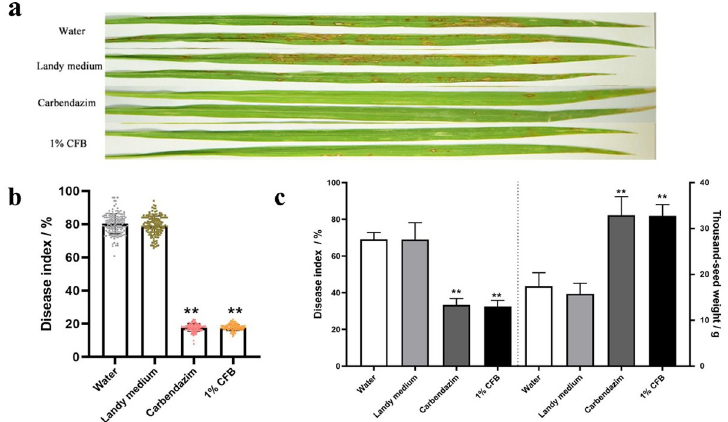
Fig 6. In the field conditions, the antifungal substances of ZW10 were evaluated regarding control of rice blast. The outbreak of leaf blast was different in different treatments (a), resulting in significant treatment differences in disease index (b). The treatment effects on the neck blast disease index and its thousand-seed weight (c). Data are presented as means of three replicates ± SD.